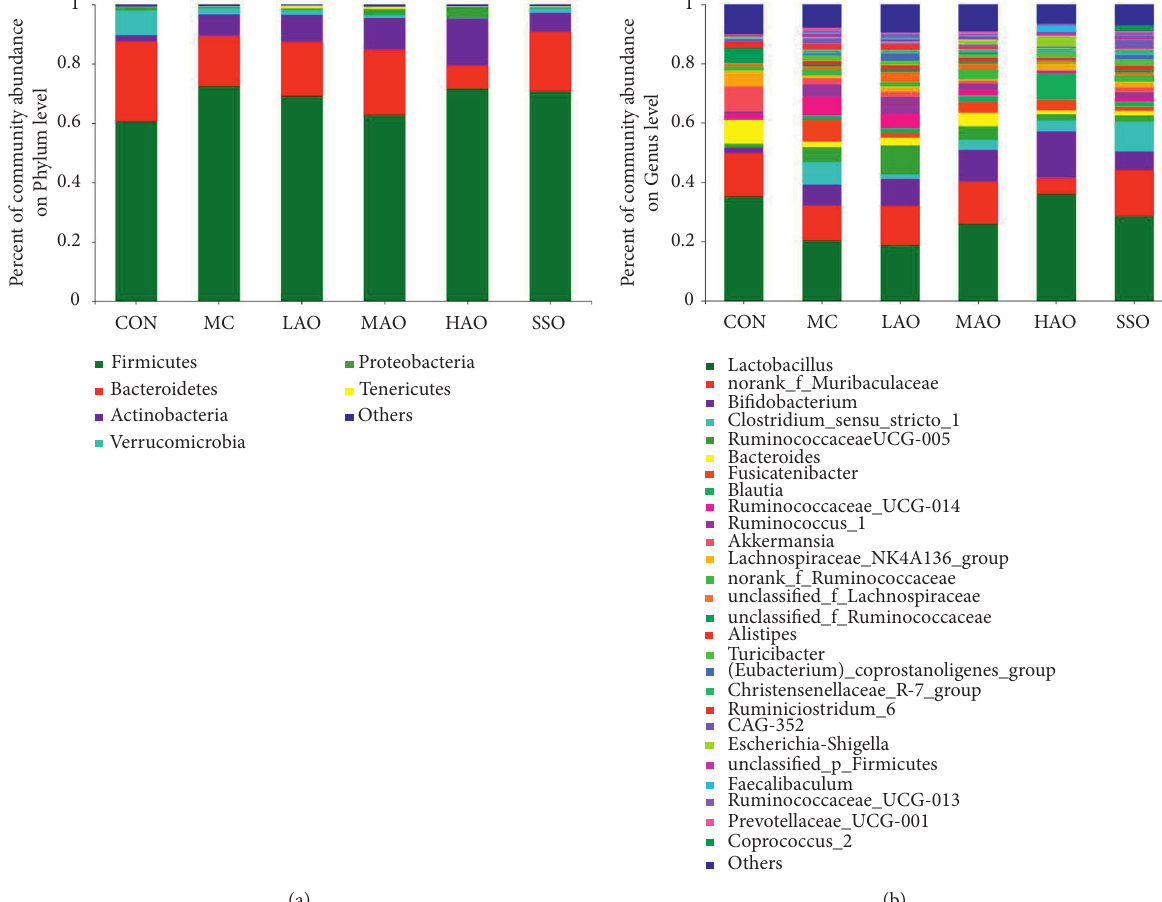
Figure 10: Modulation effect of almond oil on the gut microbiota in rats. (a) The effect of almond oil on microbial community structures at the phylum level. (b) The effect of almond oil on relative abundances at the genus